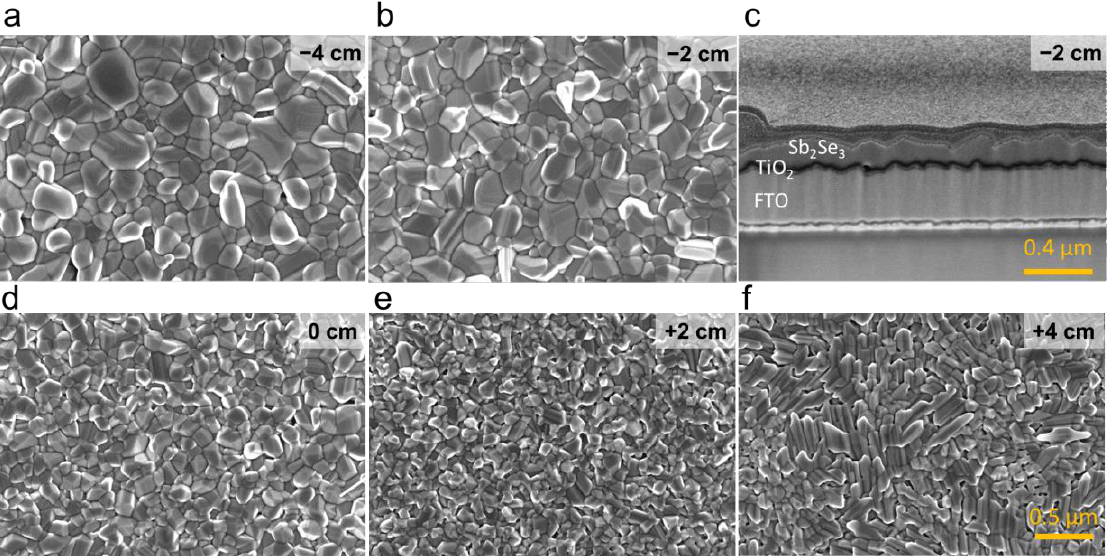
Figure 1. Top-view ( a , b , d – f ) SEM micrograph of Sb 2 Se 3 seed layer deposited at different sample heating zone distances indicated in the image. ( c ) SEM image of FTO/TiO 2 /Sb 2 Se 3 -seed layer structure cross-section deposited at d = −2 cm.